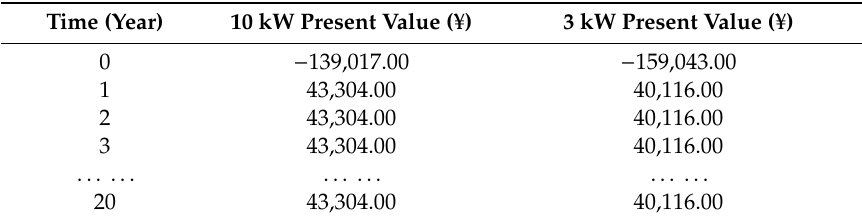
Table 2. Calculation of NPV of WECS.